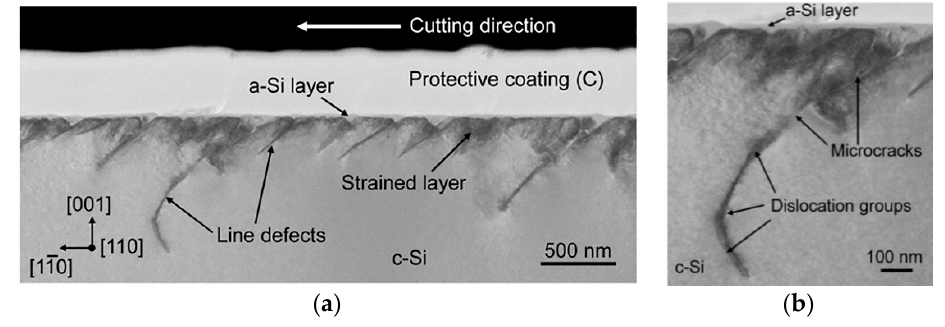
Figure 14. XTEM micrographs of a sample cut along 0° direction: ( a ) general view; ( b ) closeup bright and dark field views [41].